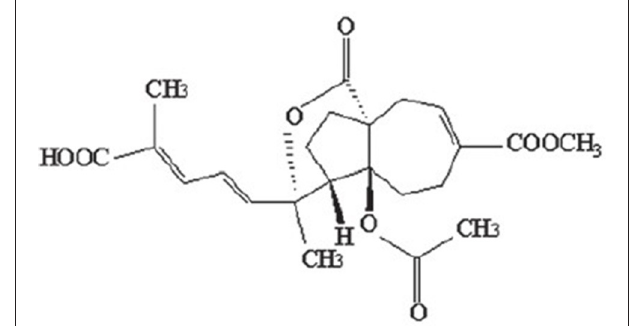
FIGURE 1 | Chemical structure of